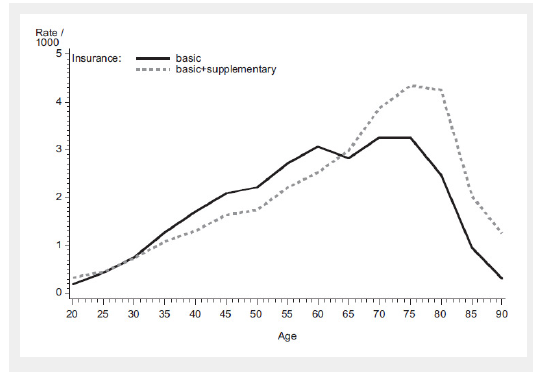
Figure 3 Incidence of in spinal surgery in populations with basic or basic plus supplementary health